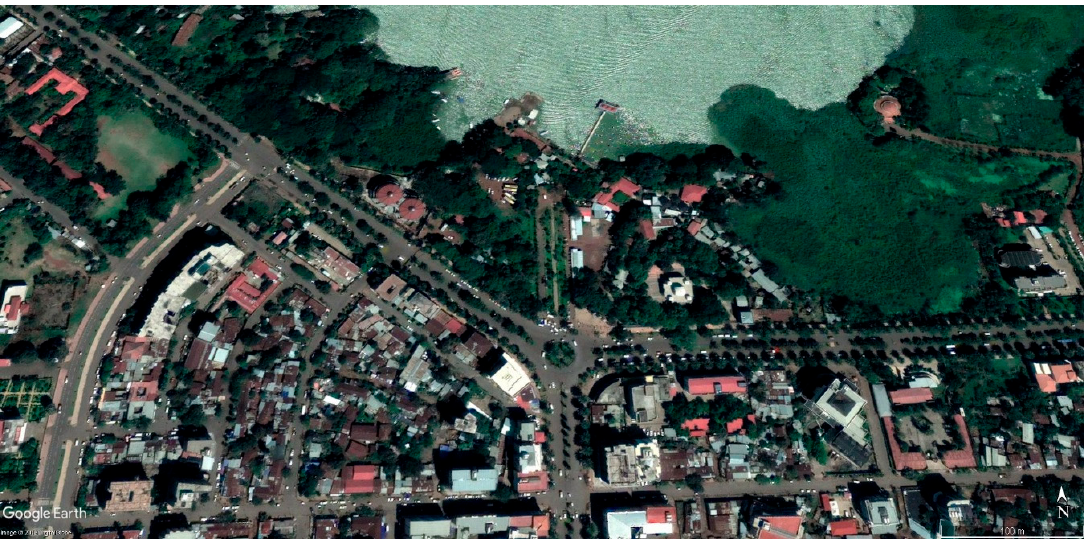
Figure 2. Part of Bahir Dar city shown in a high-resolution satellite image from 2015 (Source: Google Earth).